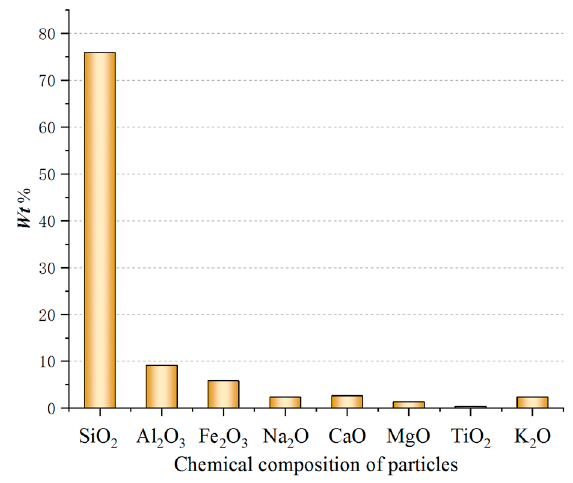
Figure 10. Chemical composition of the test sand.